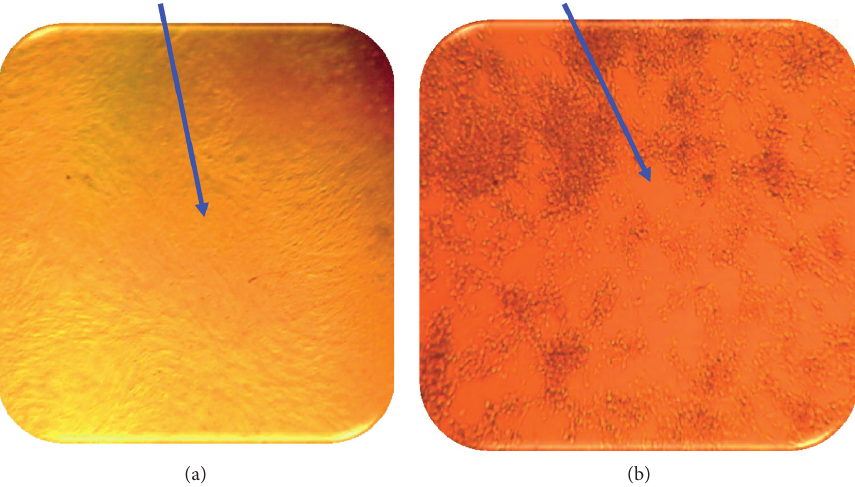
Figure 2: Picture taken during FMDV virus isolation: (a) BHK-21 cell control (cell without FMDV infection); (b) virus-induced cytopathic effect (indicated by arrow) inoculated with FMDV outbreak